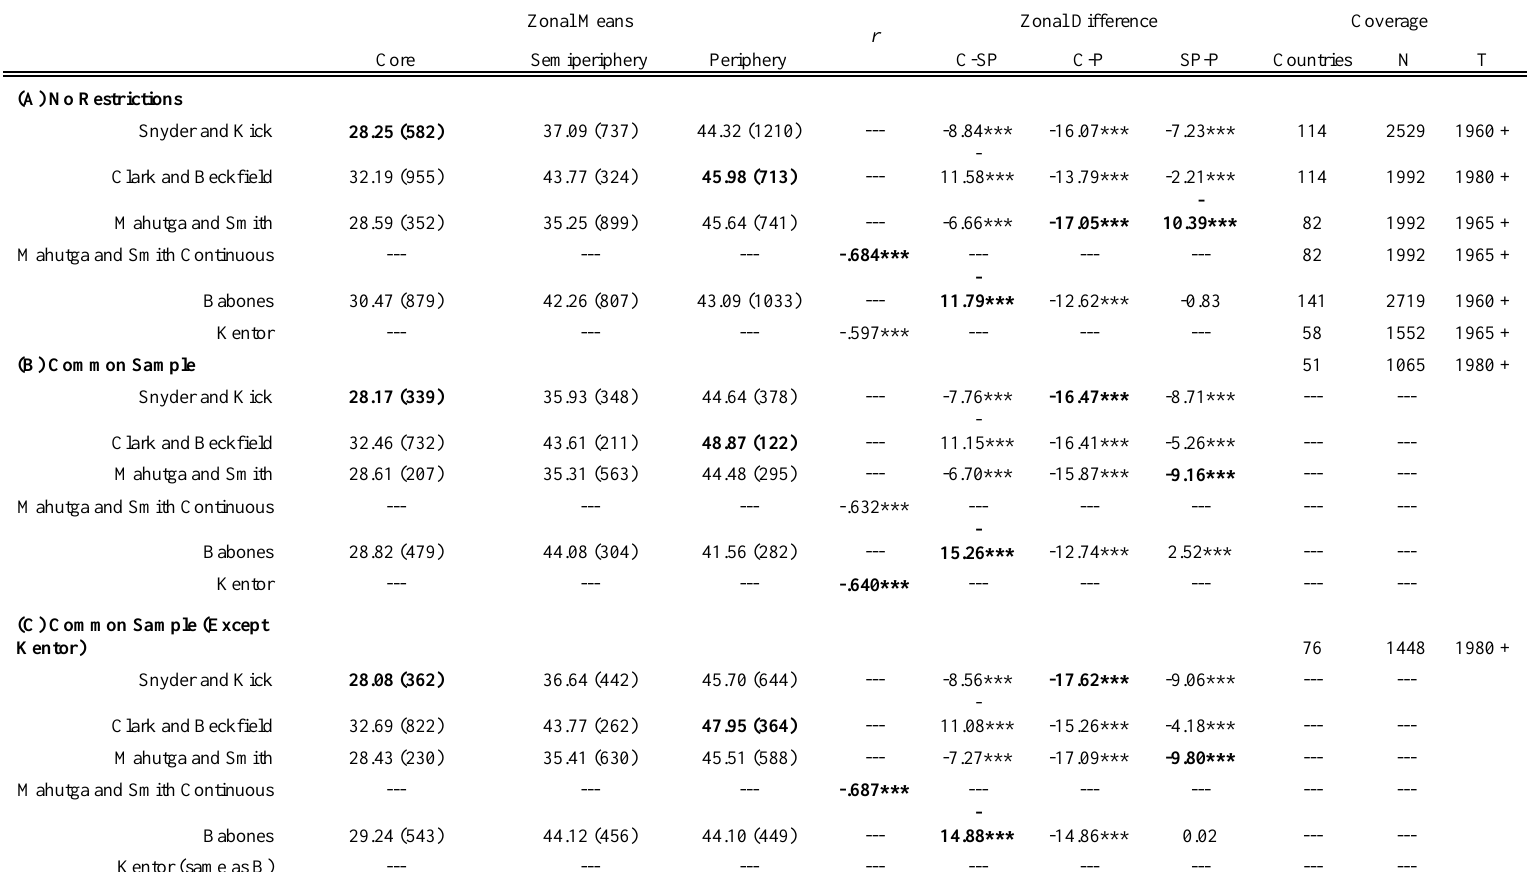
Table 3. Bivariate Descriptive Statistics for Association Between World-System Position and Gini by Sample Restriction and World-System